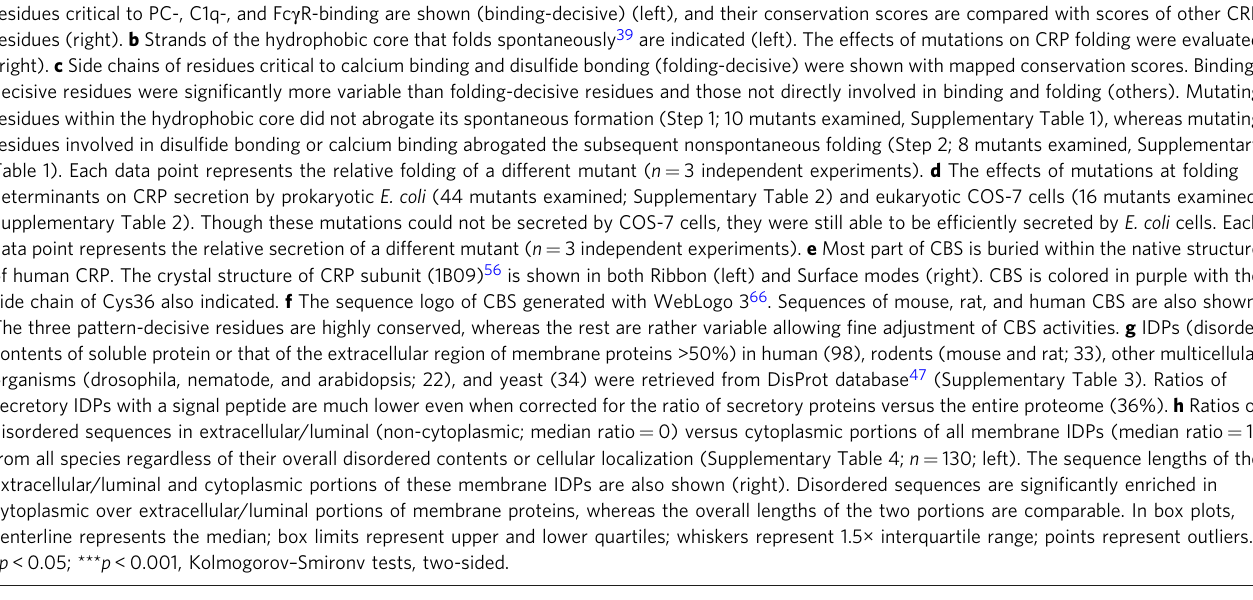
Fig. 5 Folding determinants shape the evolutionary pattern of CRP. Conservation scores of CRP were calculated with Consurf 40 using 121 available amino acid sequences of different species. a Conservation scores were mapped onto the crystal structure of the human CRP subunit (PDB 1B09) 56 . Side chains of residues critical to PC-, C1q-, and Fc γ R-binding are shown (binding-decisive) (left), and their conservation scores are compared with scores of other CRP residues (right). b Strands of the hydrophobic core that folds spontaneously 39 are indicated (left). The effects of mutations on CRP folding were evaluated (right). c Side chains of residues critical to calcium binding and disul fi de bonding (folding-decisive) were shown with mapped conservation scores. Binding- decisive residues were signi fi cantly more variable than folding-decisive residues and those not directly involved in binding and folding (others). Mutating residues within the hydrophobic core did not abrogate its spontaneous formation (Step 1; 10 mutants examined, Supplementary Table 1), whereas mutating residues involved in disul fi de bonding or calcium binding abrogated the subsequent nonspontaneous folding (Step 2; 8 mutants examined, Supplementary Table 1). Each data point represents the relative folding of a different mutant ( n = 3 independent experiments). d The effects of mutations at folding determinants on CRP secretion by prokaryotic E. coli (44 mutants examined; Supplementary Table 2) and eukaryotic COS-7 cells (16 mutants examined; Supplementary Table 2). Though these mutations could not be secreted by COS-7 cells, they were still able to be ef fi ciently secreted by E. coli cells. Each data point represents the relative secretion of a different mutant ( n = 3 independent experiments). e Most part of CBS is buried within the native structure of human CRP. The crystal structure of CRP subunit (1B09) 56 is shown in both Ribbon (left) and Surface modes (right). CBS is colored in purple with the side chain of Cys36 also indicated. f The sequence logo of CBS generated with WebLogo 3 66 . Sequences of mouse, rat, and human CBS are also shown. The three pattern-decisive residues are highly conserved, whereas the rest are rather variable allowing fi ne adjustment of CBS activities. g IDPs (disorder contents of soluble protein or that of the extracellular region of membrane proteins >50%) in human (98), rodents (mouse and rat; 33), other multicellular organisms (drosophila, nematode, and arabidopsis; 22), and yeast (34) were retrieved from DisProt database 47 (Supplementary Table 3). Ratios of secretory IDPs with a signal peptide are much lower even when corrected for the ratio of secretory proteins versus the entire proteome (36%). h Ratios of disordered sequences in extracellular/luminal (non-cytoplasmic; median ratio = 0) versus cytoplasmic portions of all membrane IDPs (median ratio = 1) from all species regardless of their overall disordered contents or cellular localization (Supplementary Table 4; n = 130; left). The sequence lengths of the extracellular/luminal and cytoplasmic portions of these membrane IDPs are also shown (right). Disordered sequences are signi fi cantly enriched in cytoplasmic over extracellular/luminal portions of membrane proteins, whereas the overall lengths of the two portions are comparable. In box plots, centerline represents the median; box limits represent upper and lower quartiles; whiskers represent 1.5× interquartile range; points represent outliers.